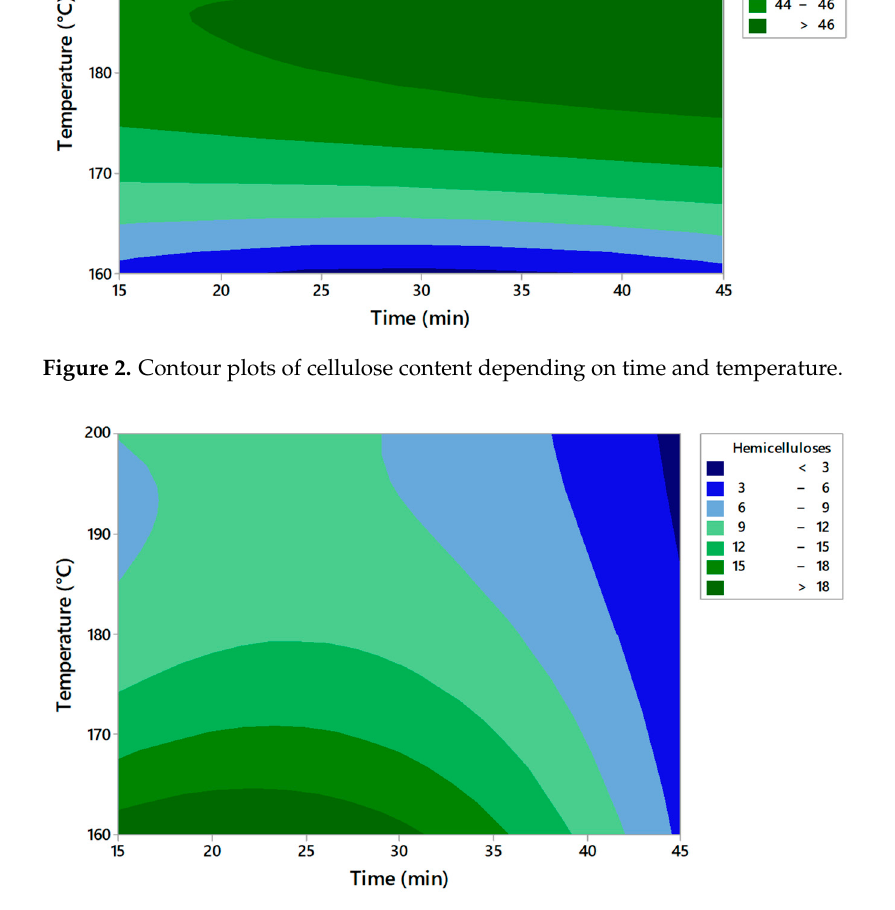
Figure 3. Contour plots of hemicellulose content depending on time and temperature.